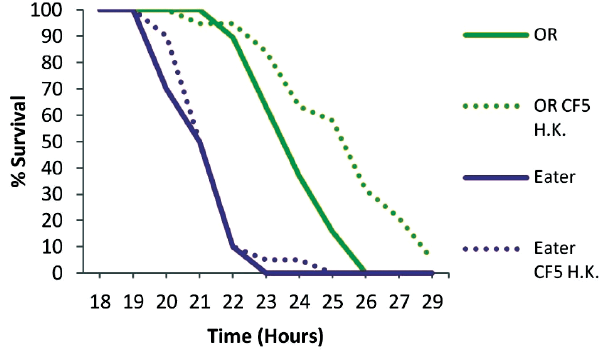
Figure 5. Survival kinetics of wt and cellular response deficient flies 5 days post priming with heat-killed Pseudomonas aeruginosa CF5. Wild type Oregon R (OR) and Eater mutant flies where challenged with PA14 5 days post injecting with heat-killed CF5. Eater mutants were equally susceptible to non primed flies (P=0.5616) in contrast to control OR flies (P=0.0037). This apparent cellular response suggests that phagocytosis efficacy depends on the priming period prior to challenge. n=19–20 flies per condition.